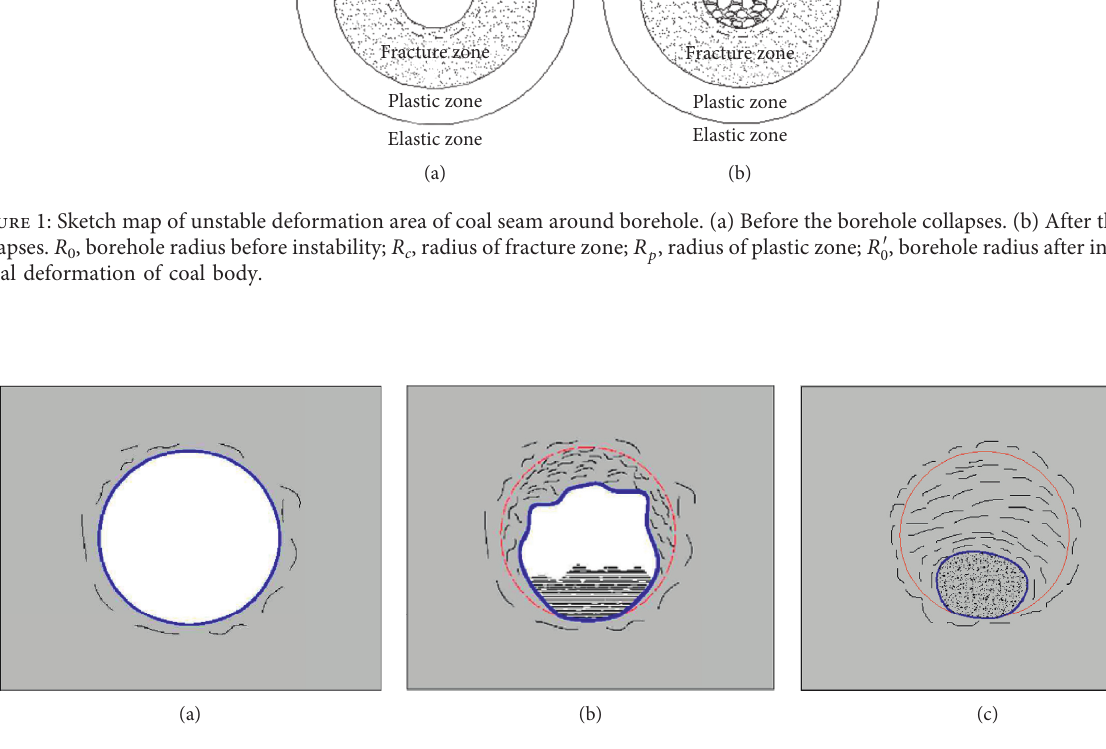
Figure 2: Scheme of borehole deformation and instability. (a) Complete hole. (b) Collapse hole. (c) Blocked